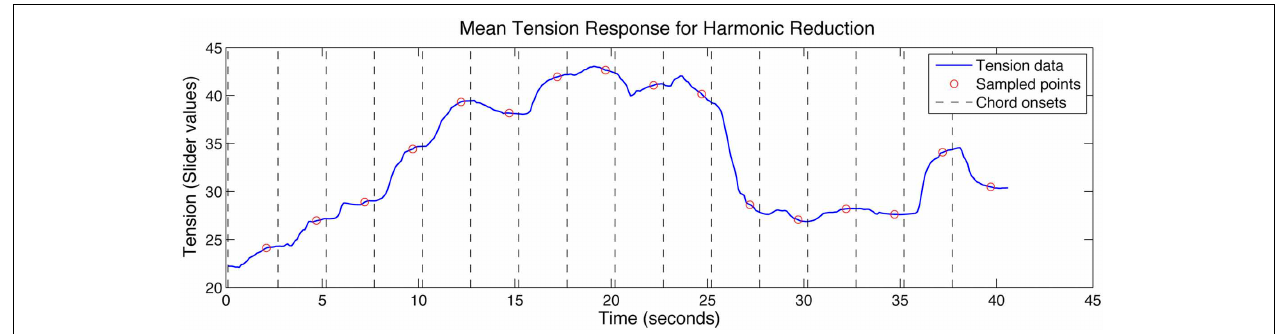
FIGURE 2 | Mean tension response to the harmonic reduction (second trial only) showing chord onsets and the corresponding sampled points used to describe harmonic tension for each chord change.